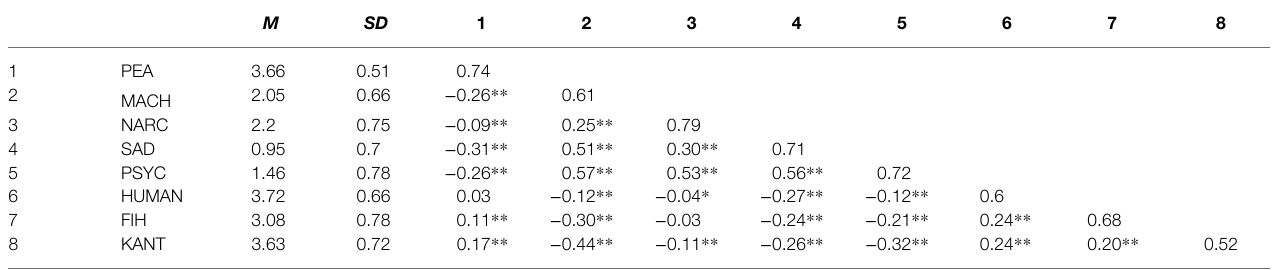
TABLE 1 | Spearman’s rank rho correlations matrix as well as reliabilities (Cronbach’s alpha, diagonal) of Study 1 ( N = 176). M SD